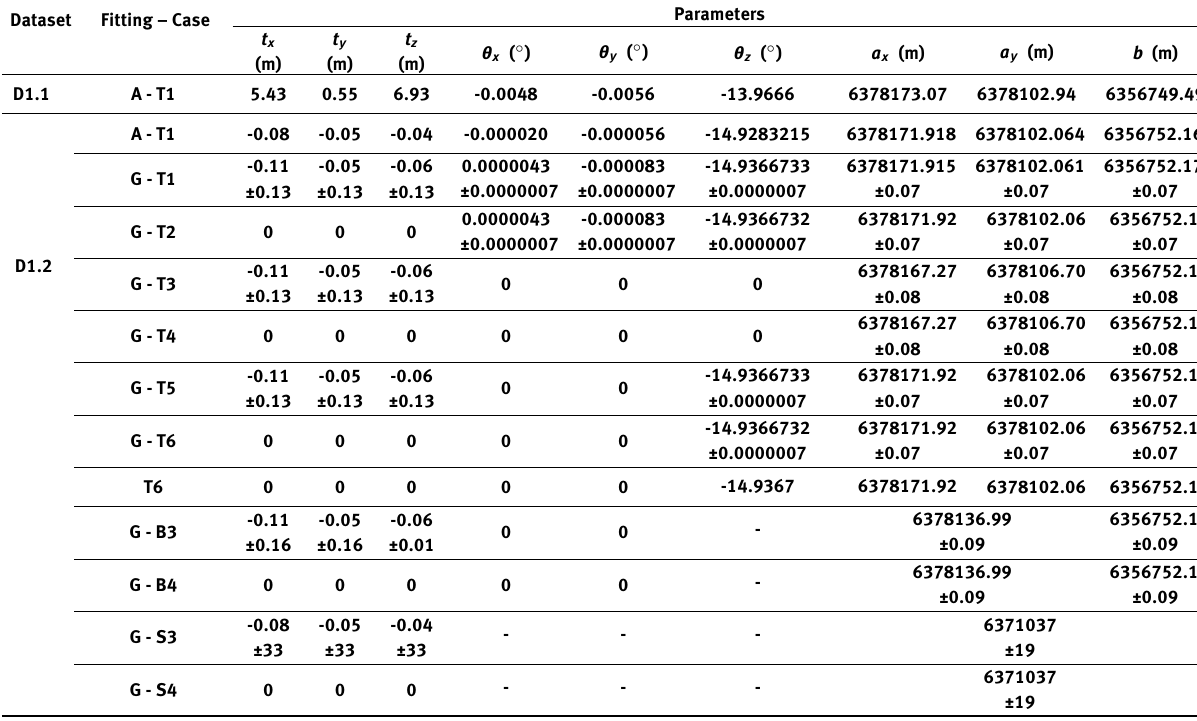
Table 5. Resulting values of the parameters of fitting for the geoid model GOCO06s Dataset